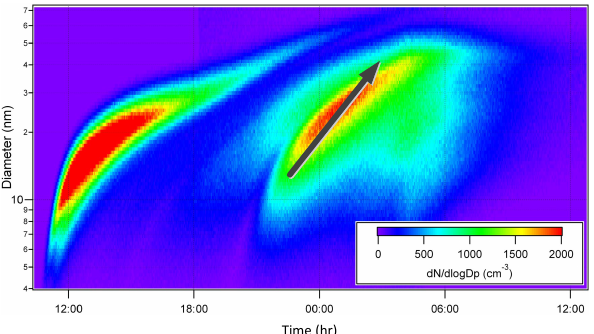
Fig. 3. The evolution of the particle size distribution in the presence of sulphuric acid, ammonia, dimethylamine and pinanediol in the CLOUD chamber. The event studied in detail (Run C, Table 1) is marked by an